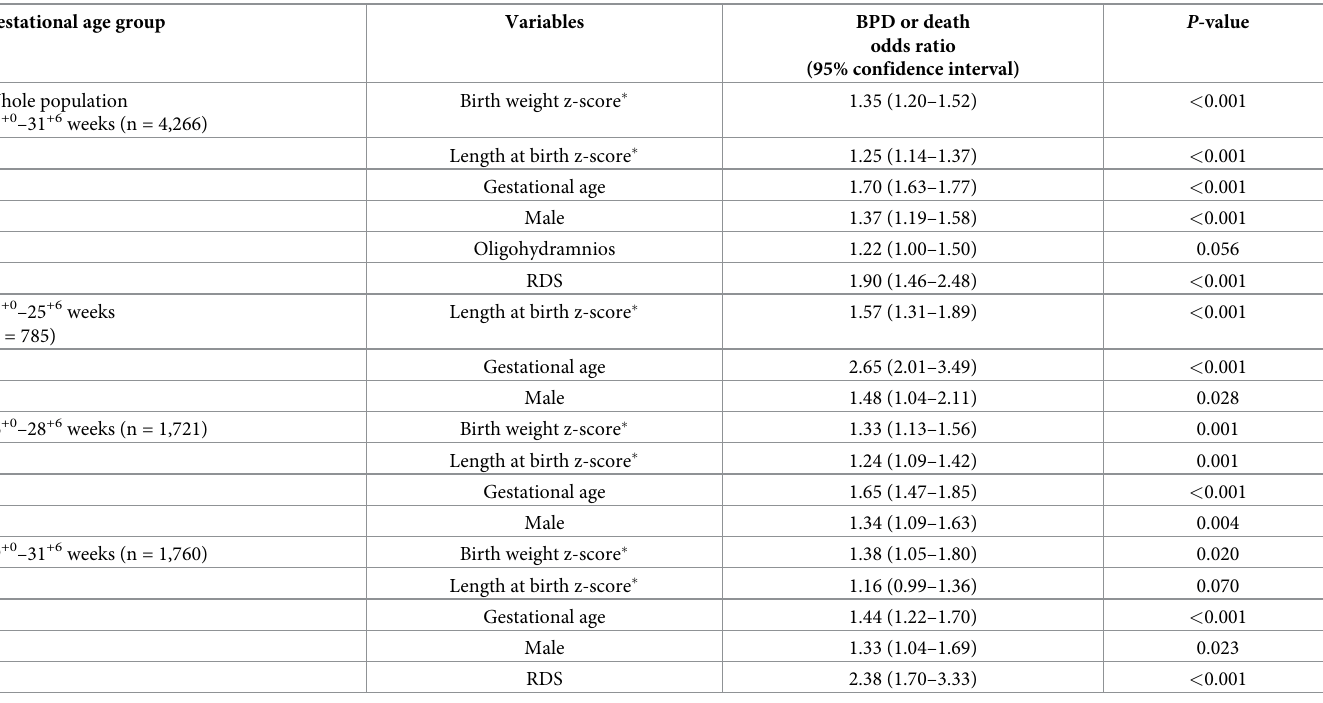
P -value odds ratio (95% confidence interval)